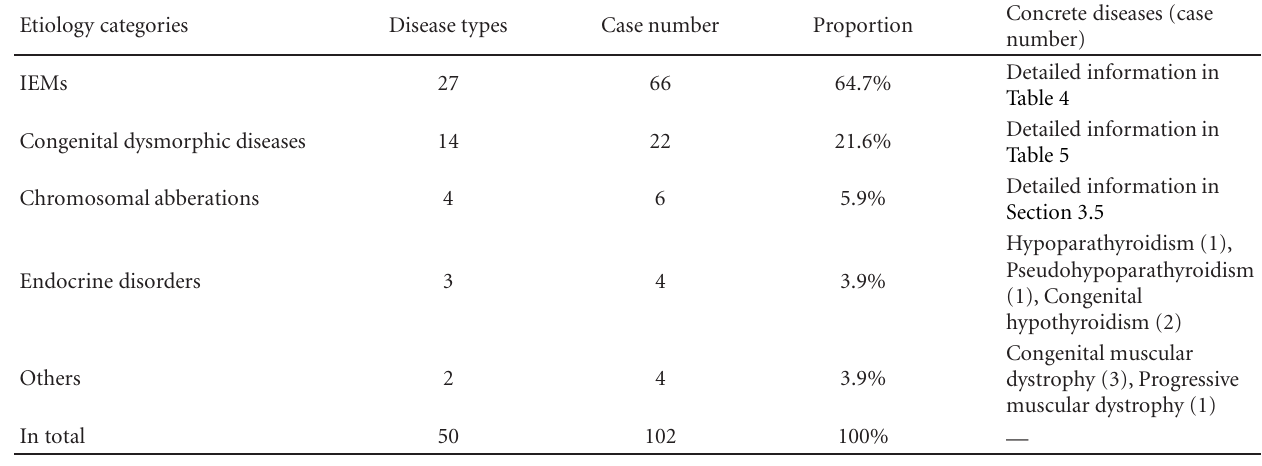
Table 3: Etiology distribution in the patients with genetic diseases in Table 2.